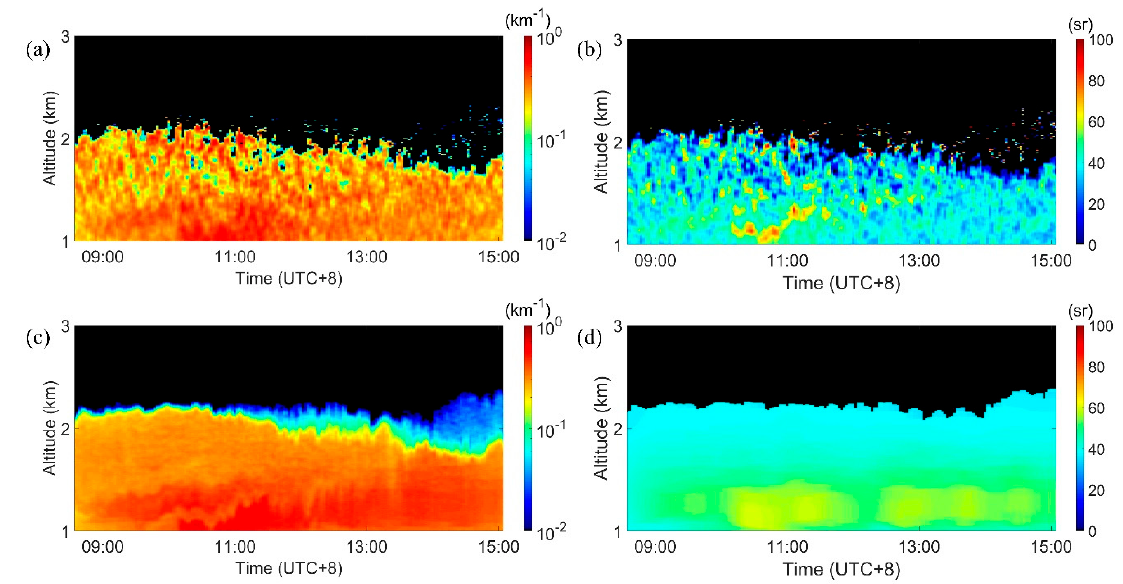
Figure 8. Comparisons of the aerosol extinction coefficient (left panel) and the lidar ratio (right panel) obtained by different methods based on the observations from Zhejiang University (ZJU) HSRL. The parameters in ( a , b ) are obtained with the standard method with the SG filter, and those in ( c , d ) are obtained with the IIR method without any extra filter.